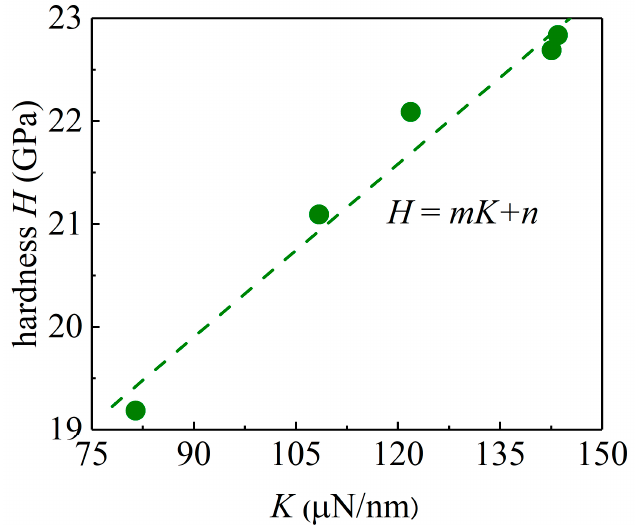
Figure 8. Relationship between the hardness H and the K values for GaN samples. The dotted straight line is a linear fit of the extracted data.